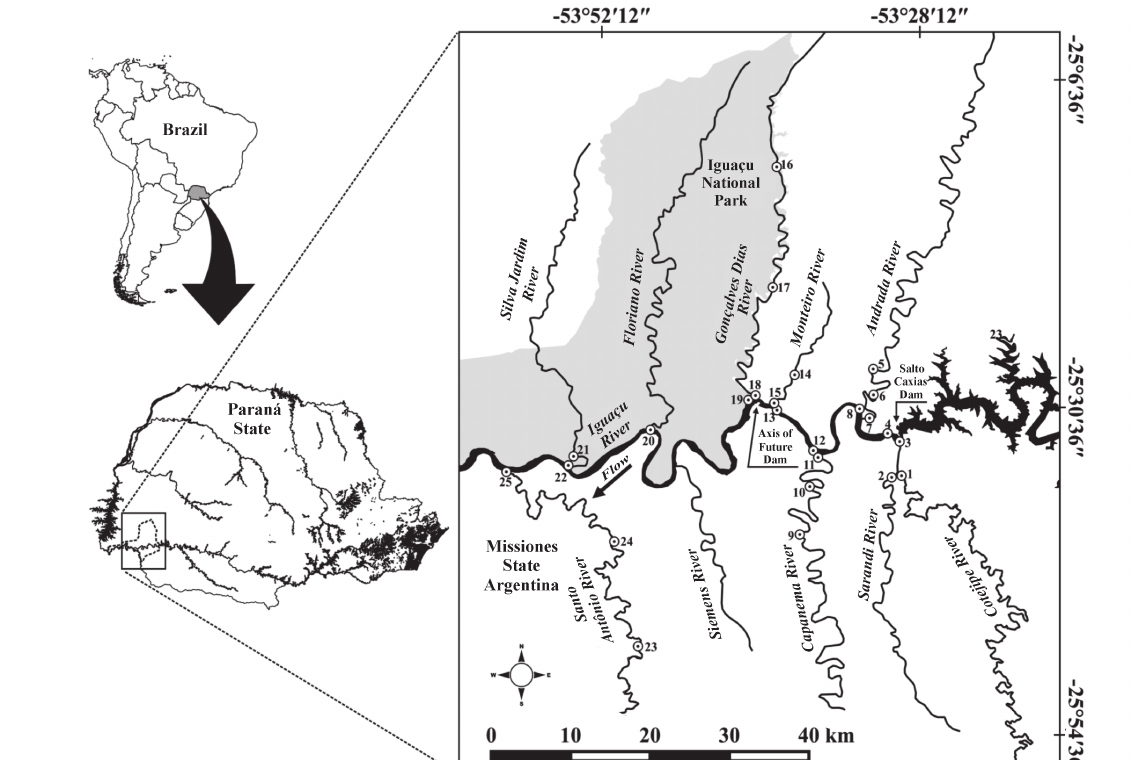
Fig.1. Study area showing the sampling sites (numbers 1 to 25) in the Lower Iguaçu River and tributaries in